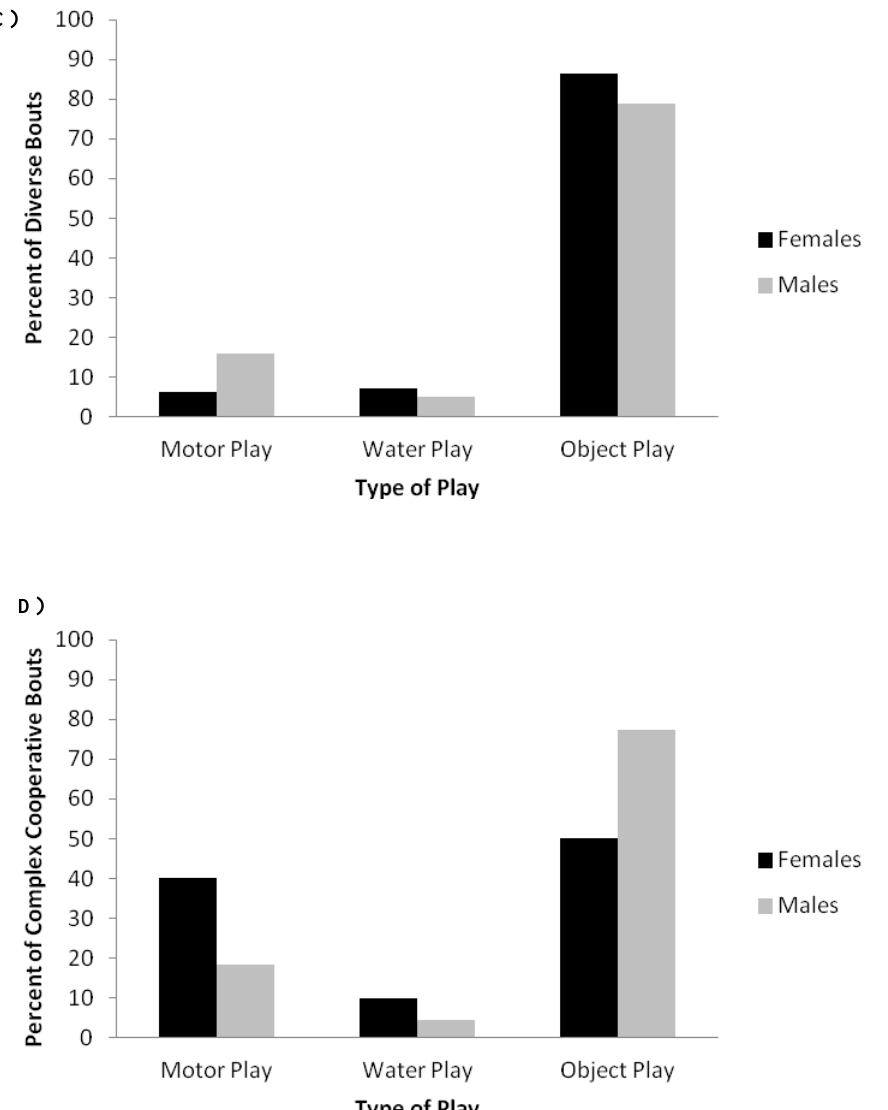
Figure 5. Percent of type of play per sex for each complexity of play category. A) Breakdown of percent of type of play for male and female belugas displaying single event bouts. B) Breakdown of percent of type of play for male and female belugas displaying diverse play bouts. C) Breakdown of percent of type of play for male and female belugas displaying repetitive play bouts. D) Breakdown of percent of type of play for male and female belugas displaying complex cooperative/social play